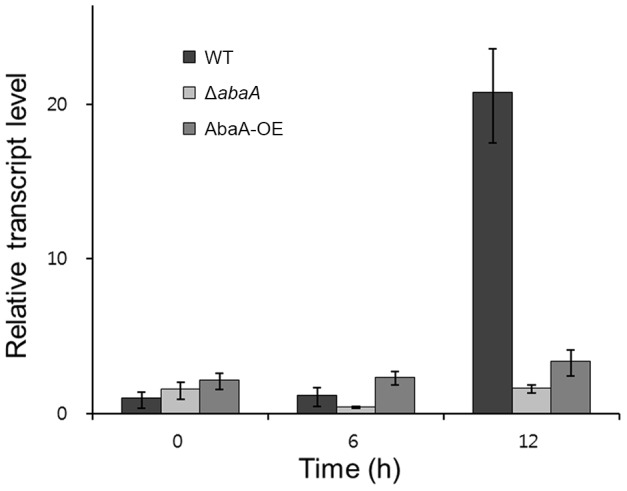
Relative transcript accumulation of wetA.The transcript levels of wetA (FGSG_17727) were analyzed by quantitative real time-PCR (qRT-PCR) during the conidium induction stage in the wild-type, abaA deletion mutant, and abaA overexpression mutant strains. WT, F. graminearum wild-type strain Z-3639; ΔabaA, abaA deletion mutant; AbaA-OE, a transgenic strain with the abaA promoter replaced with the ef1α promoter.